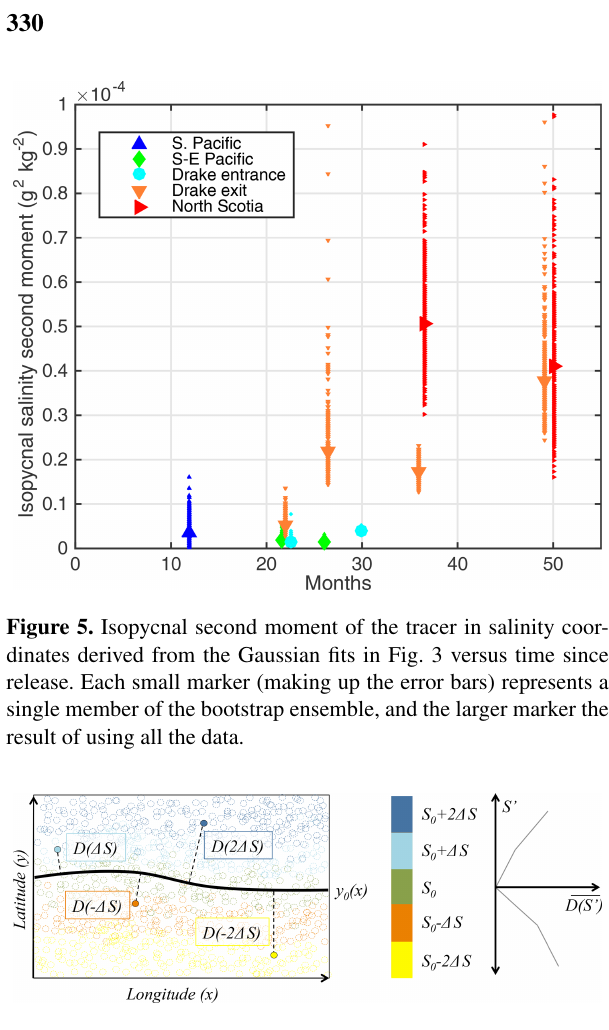
Figure 6. Schematic describing the method by which the mean dis- tance as a function of salinity anomaly ( D(S (cid:48) ) ) is calculated. Circles represent salinity observations on an isopycnal surface. The latitude of observations close to the target salinity ( S 0 ± (cid:49)S/ 2; green) are used to define a locus of latitudes ( y 0 (x) ; solid line). The mini- mum great-circle distance ( D ) of each observation from y 0 (x) is then determined and binned as a function of the salinity anomaly ( S (cid:48) = S − S 0 ). Distances are averaged within each bin, giving a re- lationship between salinity anomaly and distance D(S (cid:48) )